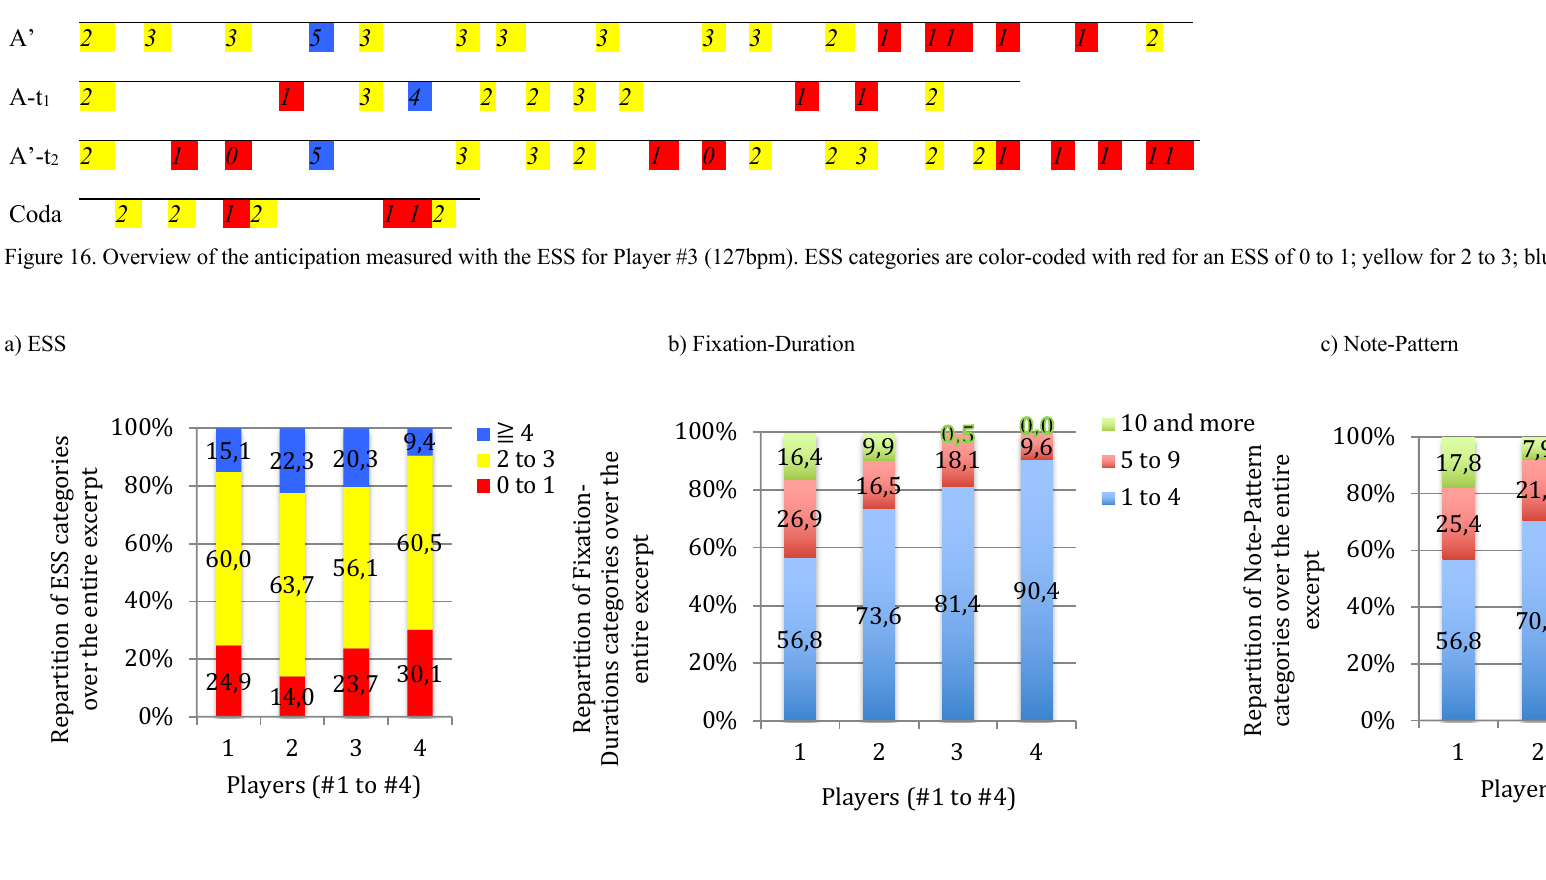
Figure 17. a) Comparison of ESS categories (in % of total ESS over the total excerpt) for all players across all tempos for the musical excerpt of ‘Porgy and Bess’. Players are numbered 1 to 4 (x-axis), and ESS are grouped in 3 categories: 0 to 1 note; 2 to 3; 4 and more. b) and c) correspond to Figures 12 (Fixation-Duration) and 14 (Note-Pattern), reported here to facilitate comparisons between